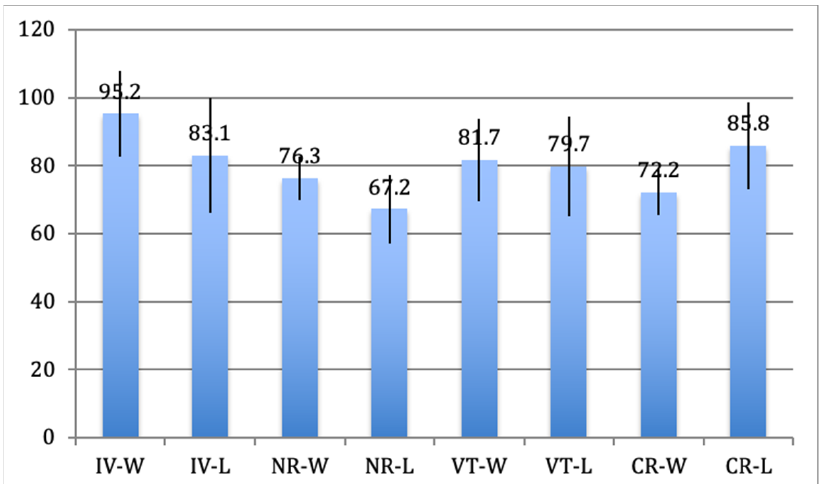
Figure 3. Mean and standard deviation for the various tested ceramics groups CR, IV, NR, and VT, mixed with H 2 O or their corresponding modeling liquids.